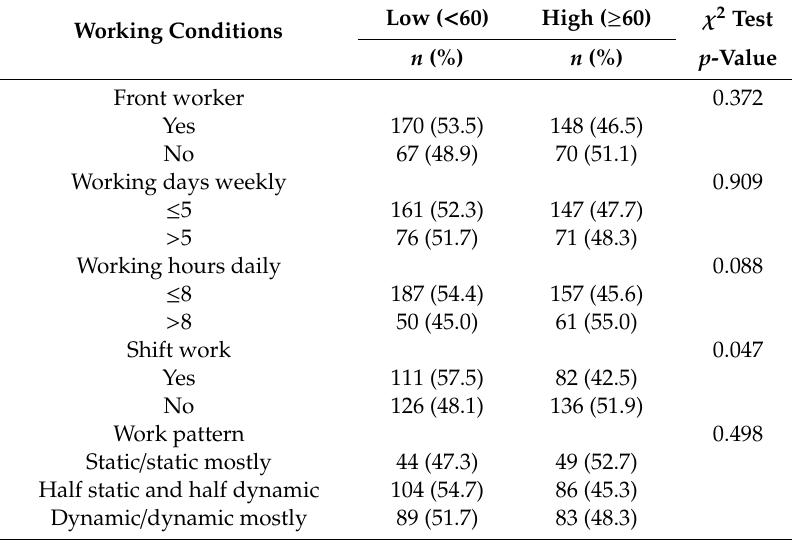
Table 5. Univariate relations of health literacy level and working